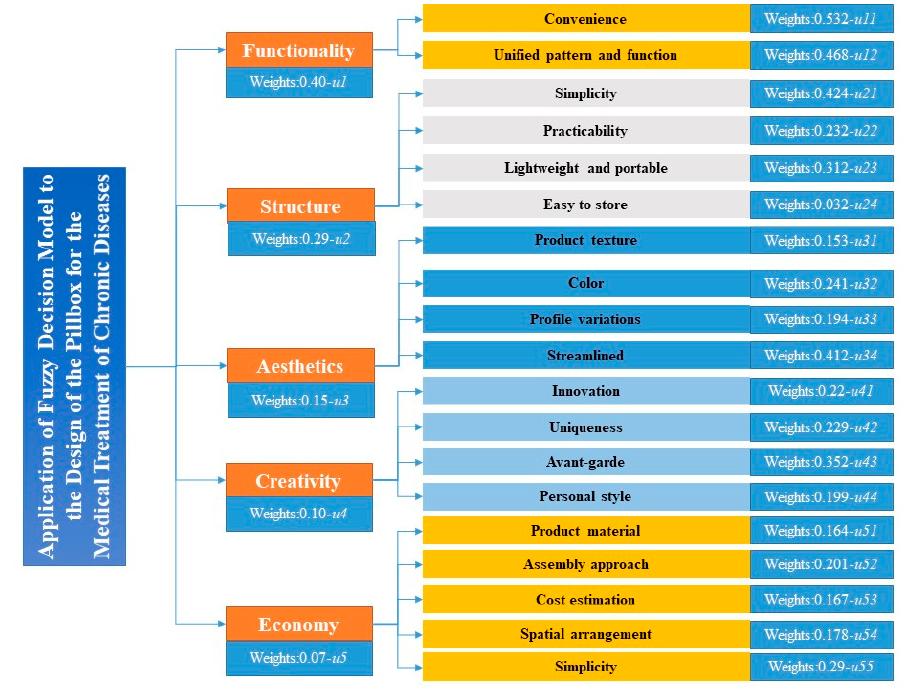
Figure 2. Weight set of the lower factors of the trolley selection indicator.